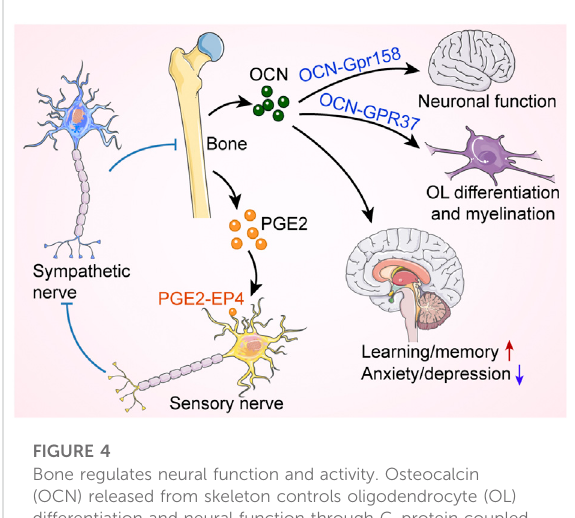
FIGURE 4 Bone regulates neural function and activity. Osteocalcin (OCN) released from skeleton controls oligodendrocyte (OL) differentiation and neural function through G-protein coupled receptors, affecting cognition and mood. Moreover, bone produces prostaglandin E2 (PGE2), which binds to EP4 receptors on sensory nerves to inhibit sympathetic nerve activity, thereby promoting bone formation. Red arrow indicates an increase, while blue arrow indicates a decrease. Blue blunt arrows ( ┴ ) indicate